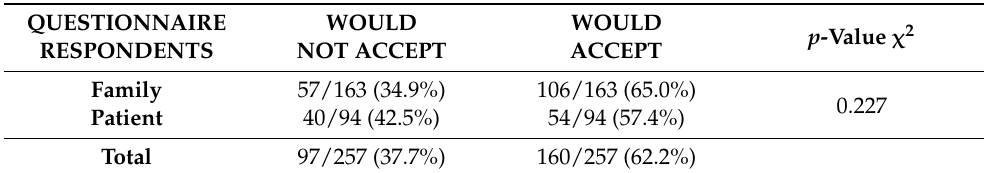
Table 5. Acceptance of treatment limitation in the event of a poor prognosis or poor future quality of life.